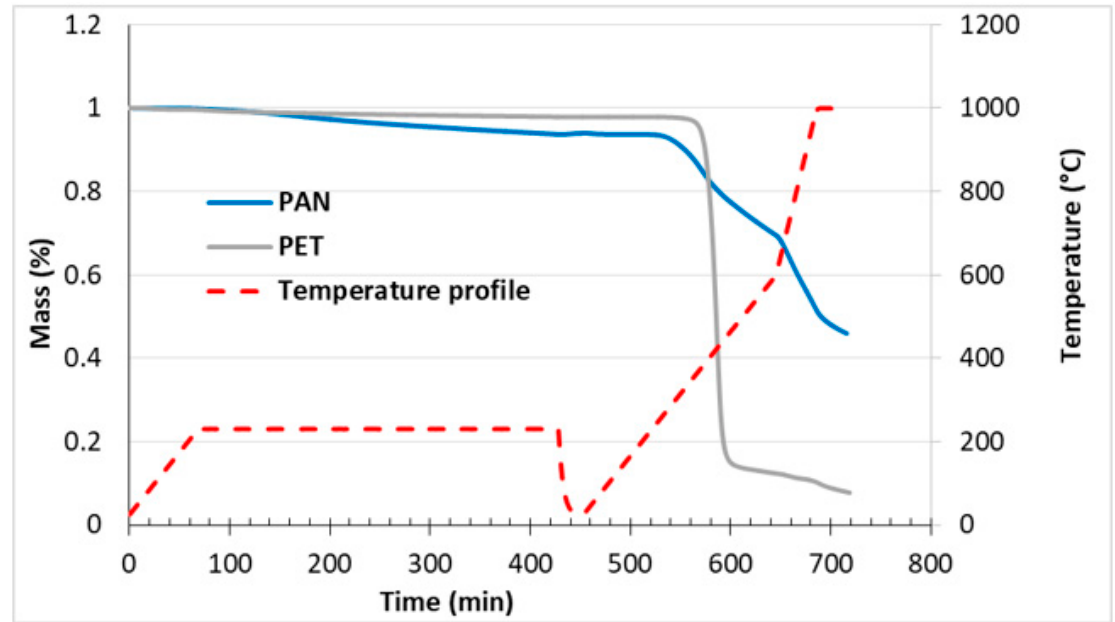
Figure 4. Temperature profile for the stabilization and carbonization processes used and corresponding TGA traces for pure PAN and PET.